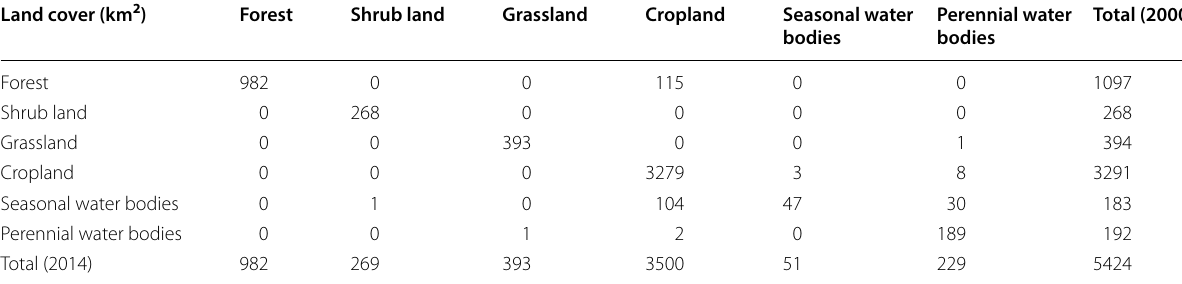
Table 4 Change matrix of land cover (km 2 ) in 2000 to 2014 Land cover (km 2